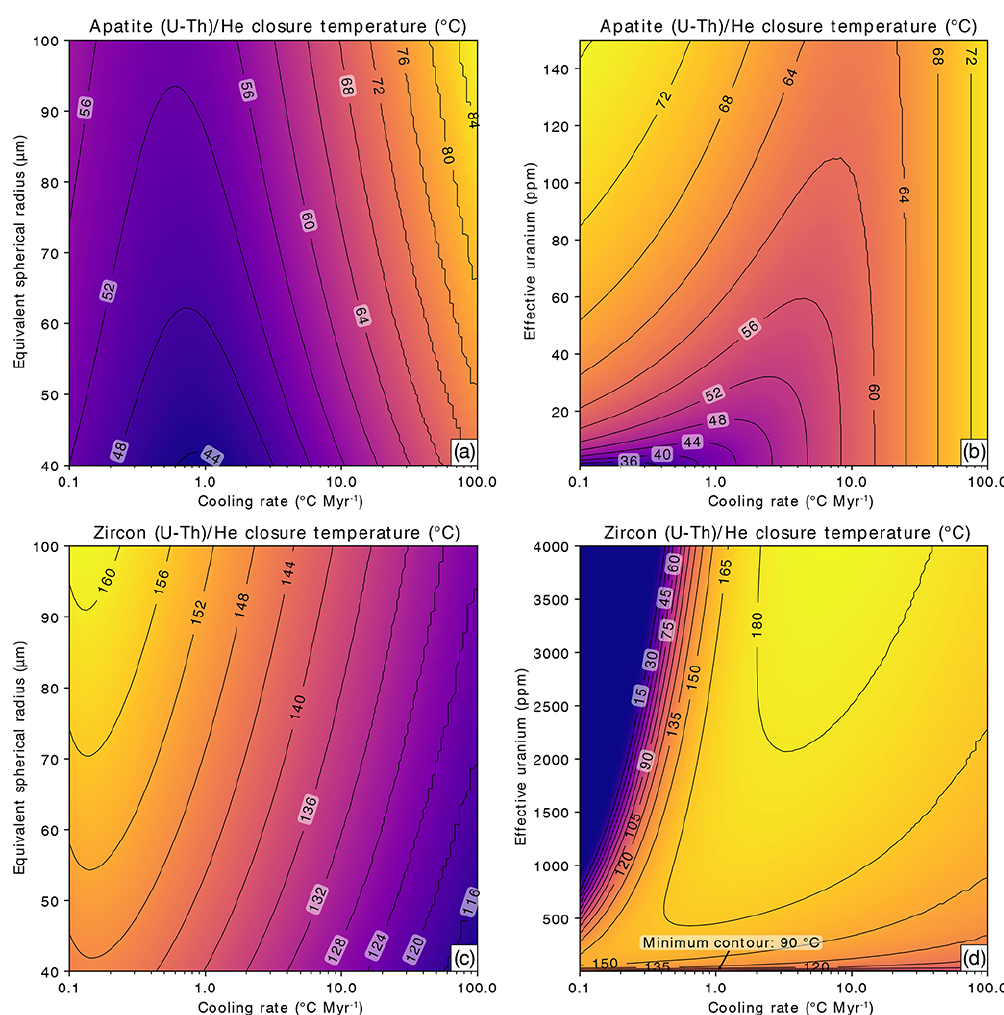
Figure 4. Contoured closure temperatures for the apatite and zircon (U-Th) / He systems as functions of cooling rate, effective spherical radius, and eU concentration. Panel (a) shows apatite where eU is fixed at 10ppm. Panel (b) shows apatite where ESR is fixed at 45µm. Panel (c) shows zircon where eU is fixed at 100ppm. Panel (d) shows zircon where ESR is fixed at 60µm The plots comprise predicted closure temperatures for 20402 forward models, and each model applies a constant cooling rate between 0.1 and 100 ◦ CMyr − 1